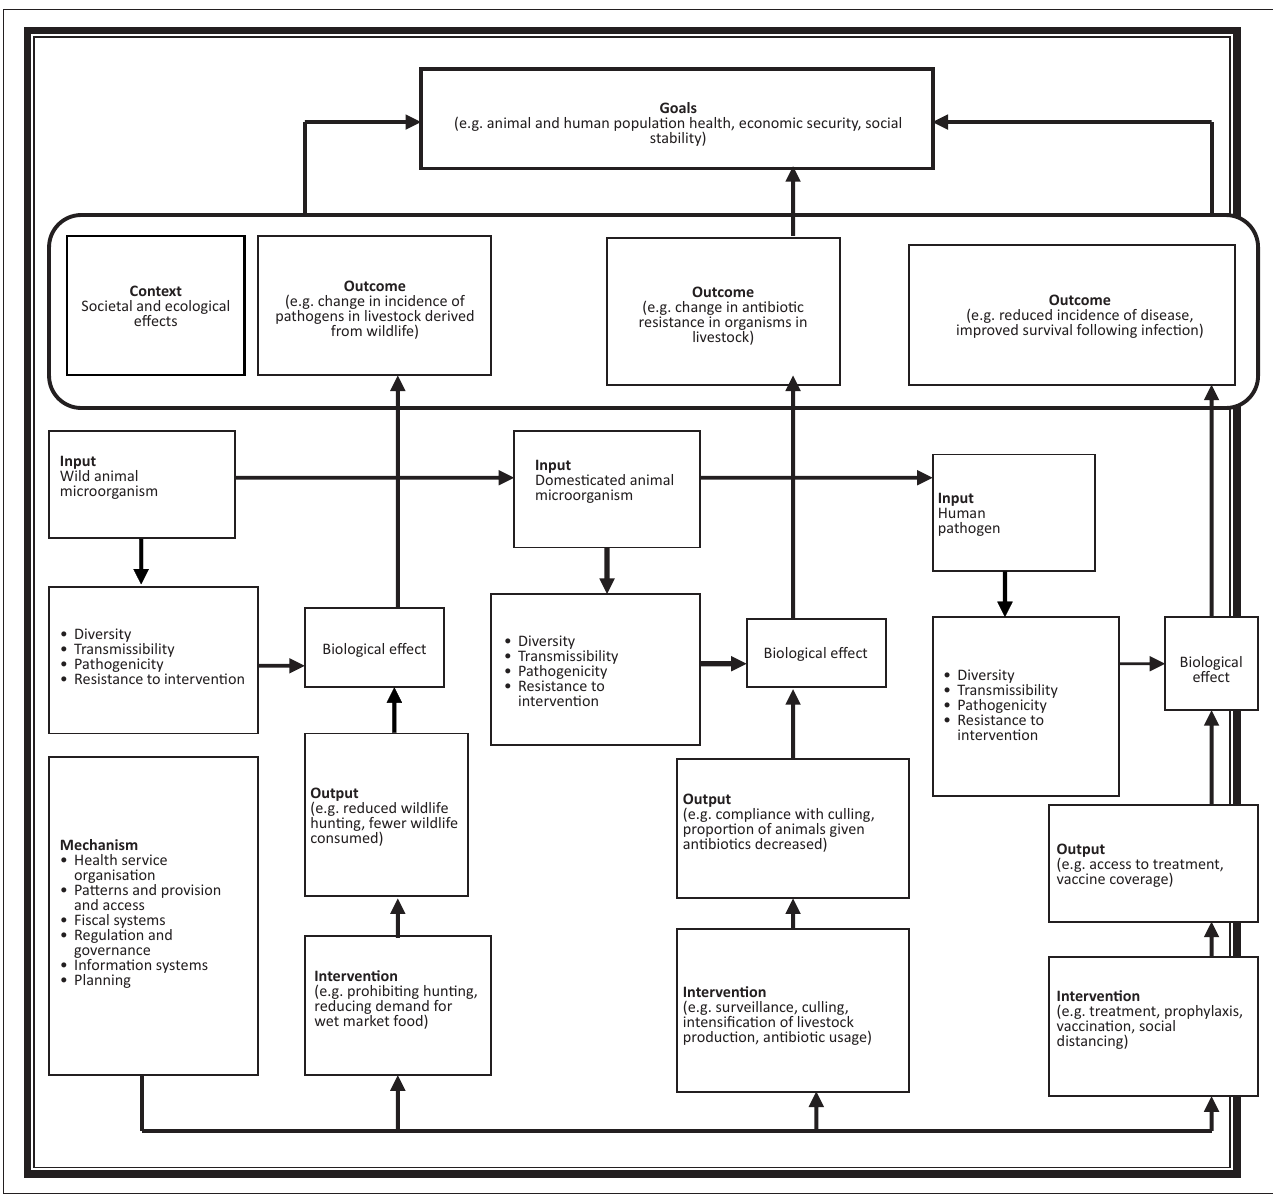
FIGURE 1: A framework for research to inform One-Health